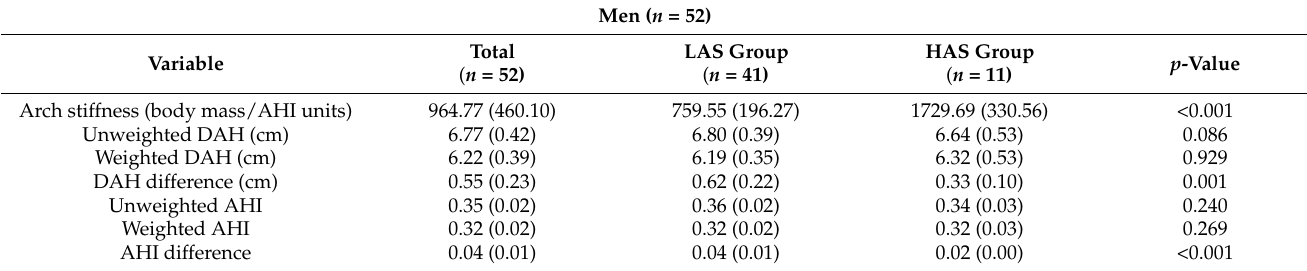
Table 3. Foot structure variables according to the groups’ comparison, for both men and